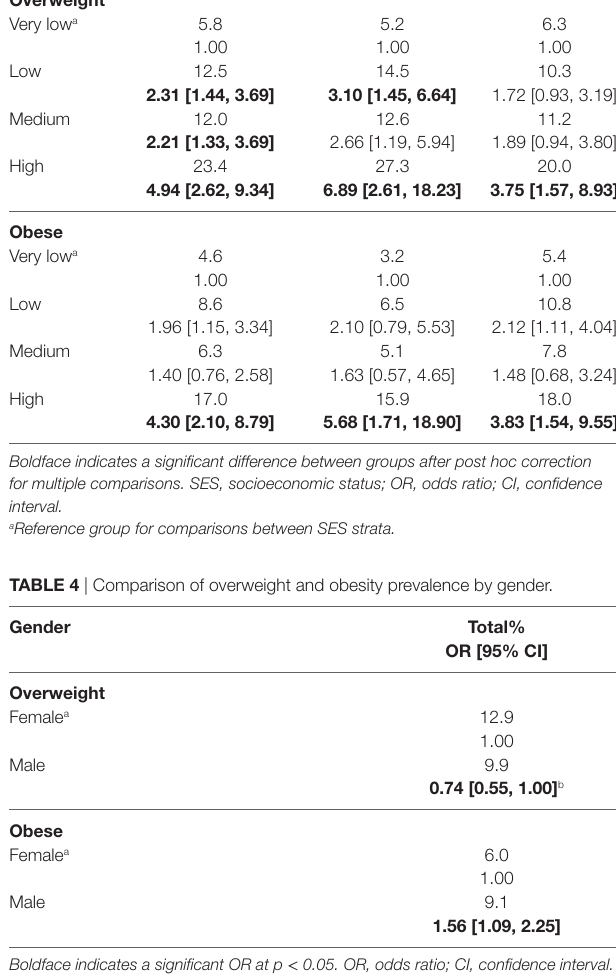
Boldface indicates a significant OR at p < 0.05. OR, odds ratio; CI, confidence interval. a Reference group for comparisons. b OR referenced to male = 1.35 [1.00, 1.82].